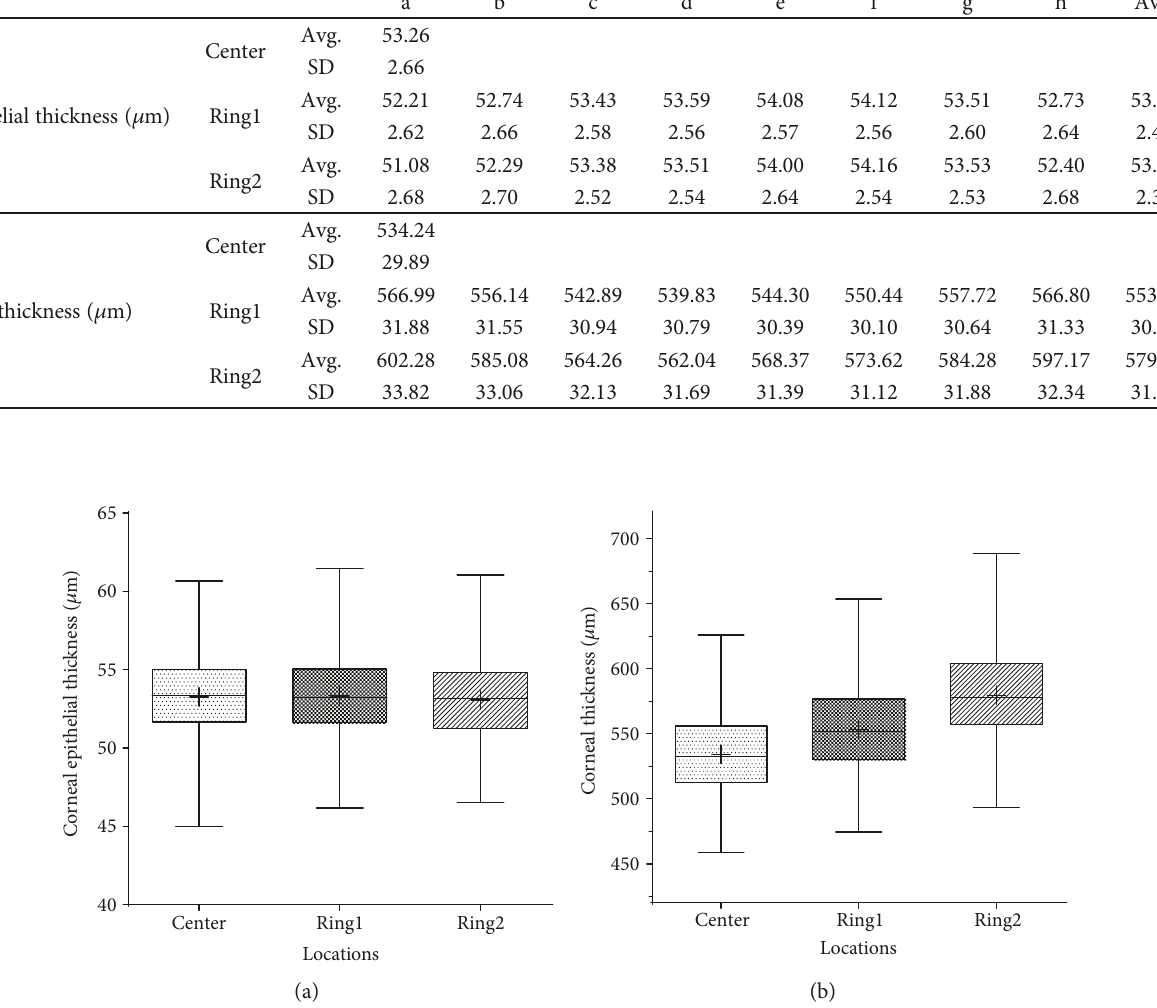
Figure 2: Box plots to show the thickness di ff erences of three locations (center, Ring1, and Ring2) in the corneal epithelial thickness map (a) and corneal thickness map (b). Corneal thickness increased from the center to the periphery (b) while corneal epithelial thickness remained constant average. The mean di ff erence between male and female in epithelial thickness value was 1.39 μ m ( P < 0 001 ).